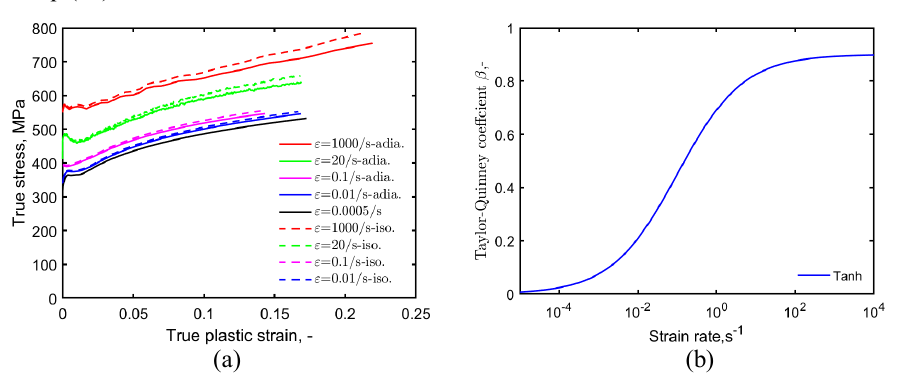
Fig. 6. (a) Adiabatic and isothermal flow curves at different strain rates; (b) The Taylor–Quinney coefficient (cid:2010) as the function of strain rate.